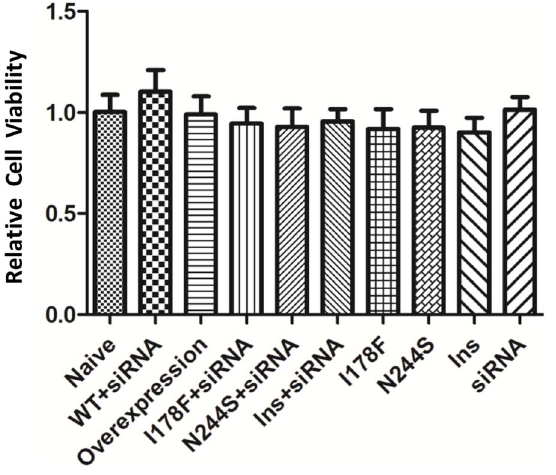
Figure 2. Cell viability of neurons with wild-type or mutant NIPA2 . Cell viability was measured by MTT detection. The absorbance of formazan was proportional to metabolic activity of the cells. Relative cell viability was calculated as: (mean absorbance of transfected group - mean absorbance of basal temperature control)/(mean absorbance of naı¨ve group - mean absorbance of basal temperature control). Naı¨ve: the cultured neurons without transfection; Overexpression: neurons transfected with NIPA2 WT ; Ins: the small insertion (N334_E335insD); siRNA: neurons transfected with NIPA2 -siRNA. Neurons were co- transfected with the mutant and NIPA2 -siRNA in the groups (I178F + siRNA, N244S + siRNA and ins + siRNA). The group (WT + siRNA) represent- ed the neurons transfected with NIPA2 WT and NIPA2 -siRNA. The mutant groups (I178F, N244S and Ins) represented the neurons transfected only with the mutant. n=9 experiments. No significant differences between naı¨ve group and any other condition were found.